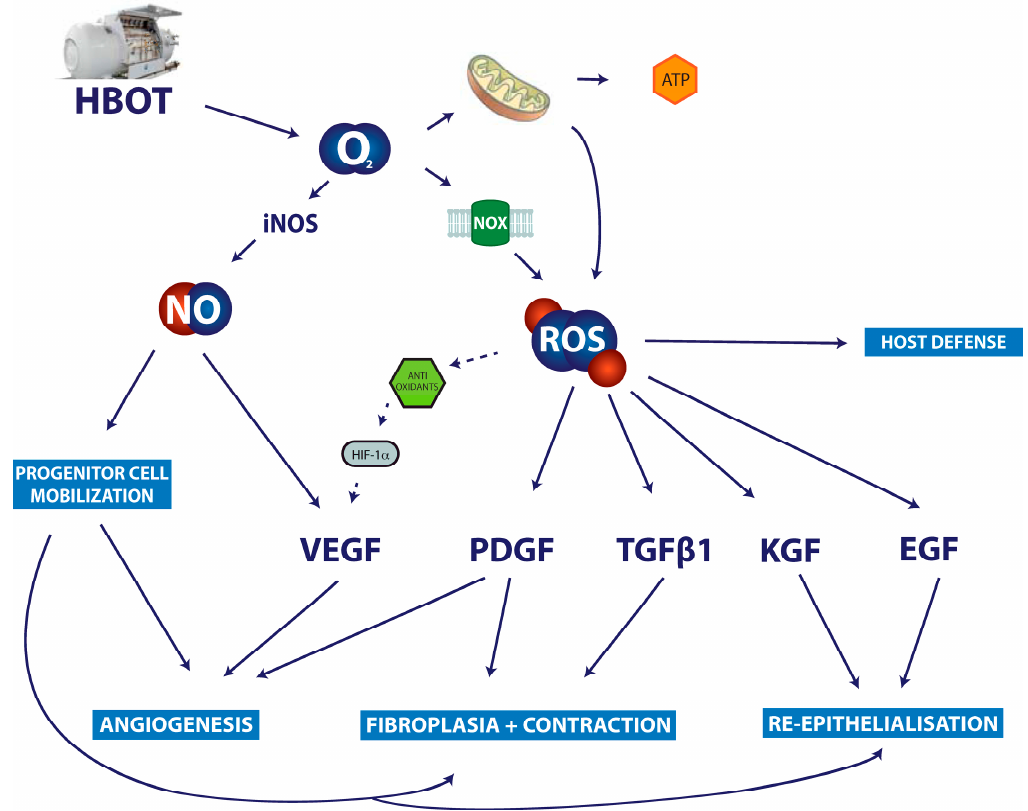
Figure 3. Proposed mechanism of action of hyperbaric oxygen therapy in the treatment of chronic wounds. Solid arrows represent direct promoting interactions and dashed arrows indirect